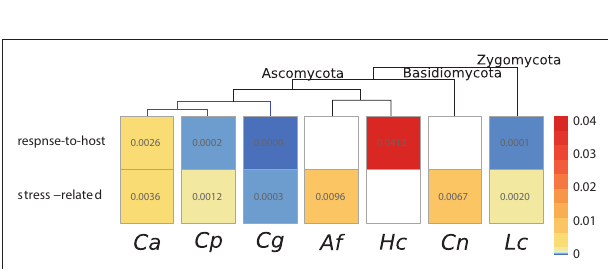
FIGURE 6 | The number of predicted alternatively spliced genes relative to the number of genes. Response-to-host and stress conditions are compared to the corresponding control